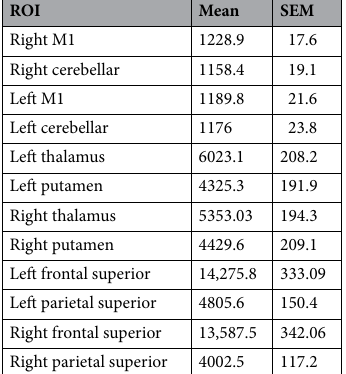
Table 1. ROI Characteristics Presented as Means and SEM of Number of functional Voxels (3 mm isovoxel). ROI region of interest, M1 motor cortex, SEM standard error of the